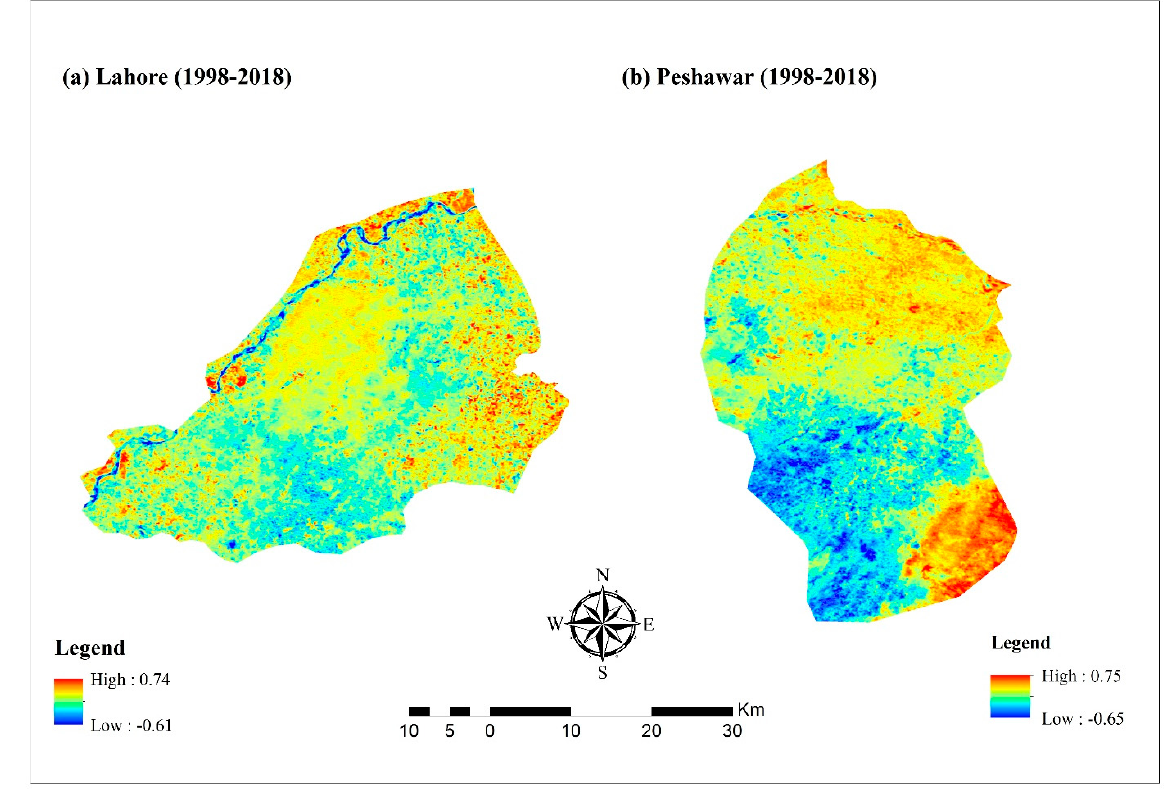
Figure 10. Regression coefficients (see color scales) between LST and LULC class transition in (a) Lahore and (b) Peshawar from 1998 to 2018.